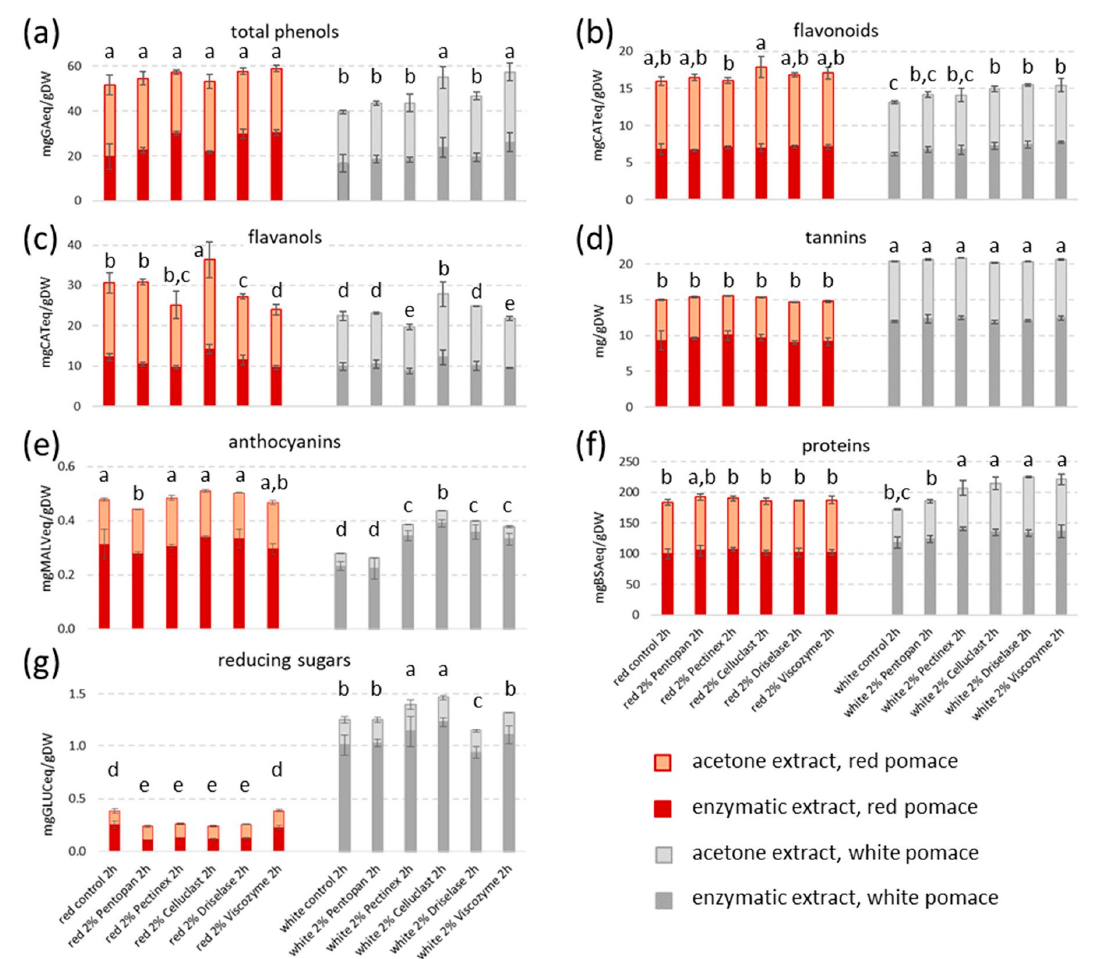
Figure 3. Contents of ( a ) total phenols, ( b ) flavonoids, ( c ) flavanols, ( d ) tannins, ( e ) anthocyanins, ( f ) proteins and ( g ) reducing sugars in red and white GP in enzymatic (2% w/w enzyme, 2 h) and acetone (75% v/v , 2 h) liquid extracts. Results are expressed as mg of standard compound (GA, gallic acid; CAT, catechin; MALV, malvidin; BSA, bovine serum albumin; GLUC, glucose) equivalents per gram of pomace dry weight (DW). Data represent the mean ± SD ( n = 3). Different letters indicate a statistically significant difference (one-way ANOVA test followed by post-hoc two-tailed Tukey test, p < 0.05) between the same type of data (total phenols, flavonoids, flavanols, tannins, anthocyanins, proteins and reducing sugars), from the highest (a) to the lowest (f). Control: treatment without the addition of enzymes incubated under the same conditions and followed by the same acetone extraction.